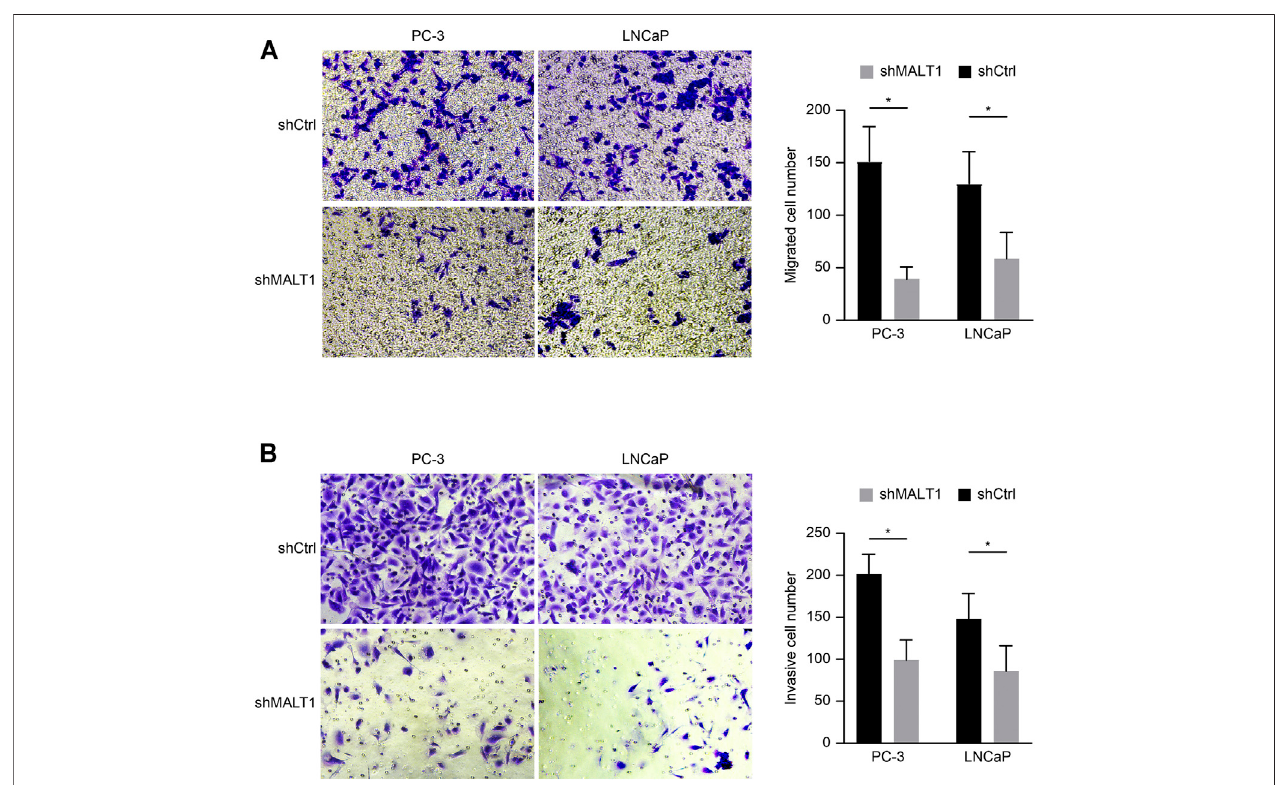
FIGURE 3 | Downregulation of MALT1 inhibited the migration and invasion of PCa cells. PCa cells were treated with a lentiviral vector for 24 h. Then, (A) PCa cell migrationabilitywastestedusingaTranswellmigrationassay. (B) PCacellinvasionabilitywastestedusingaTranswellinvasionassay.Totalmagni fi cationofallimagesis 200 × . Data are shown as mean ± SD based on at least three independent